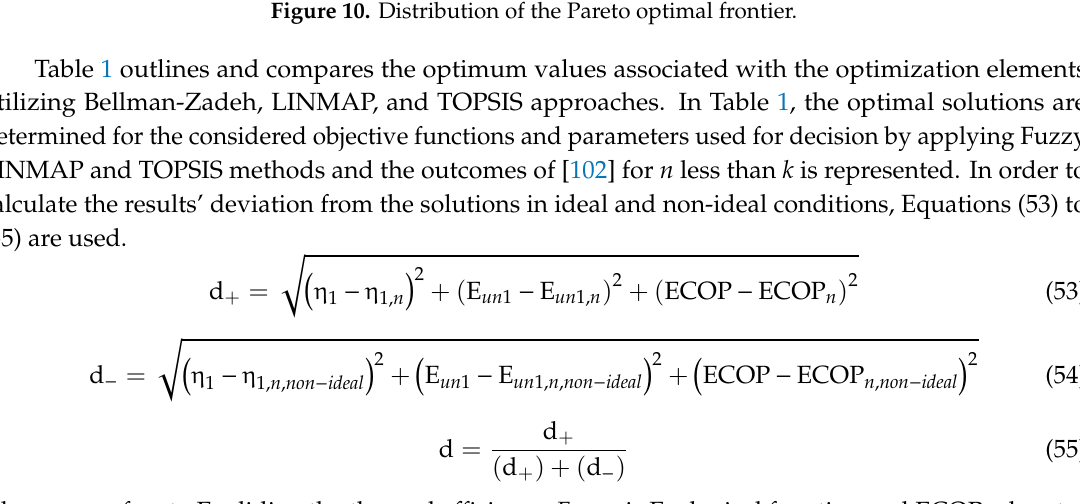
Figure 10. Distribution of the Pareto optimal frontier.